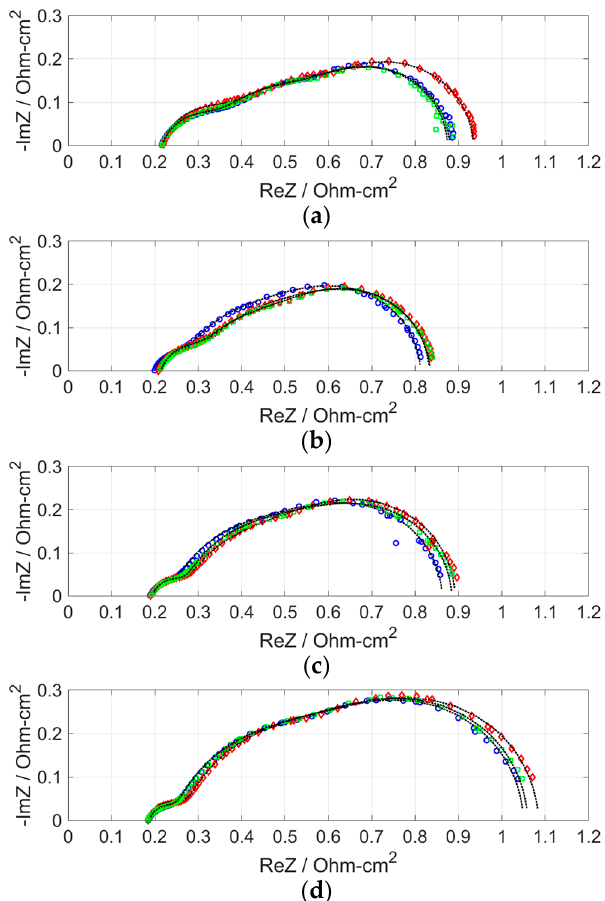
Figure 5. Effect of H 2 S on AC impedance of MEAs under various operating current density levels: ( a ) 0.2; ( b ) 0.3; ( c ) 0.4; and ( d ) 0.5 A cm − 2 . ( □ : pure H 2 ; ◇ : H 2 S; ○ : H 2 recovery; -- : fitted line). Table 2. Fitted resistances of MEAs operated at various current density levels under different